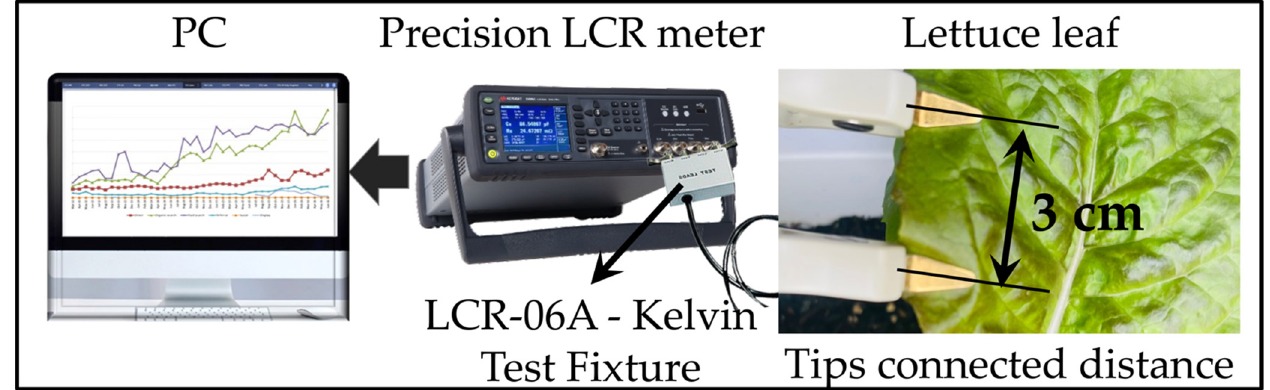
Figure 6. Impedance measurement of lettuce leaves using